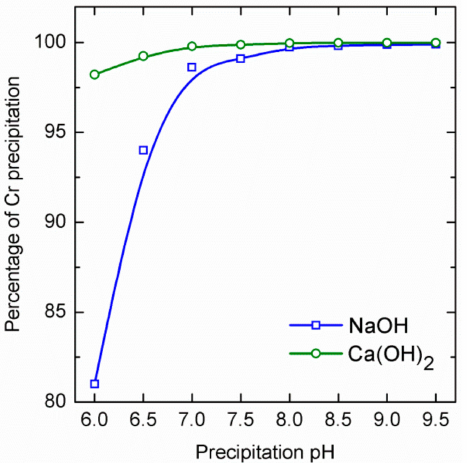
Figure 3. Cr(III) precipitation by applying common alkaline reagents at various equilibrium pH